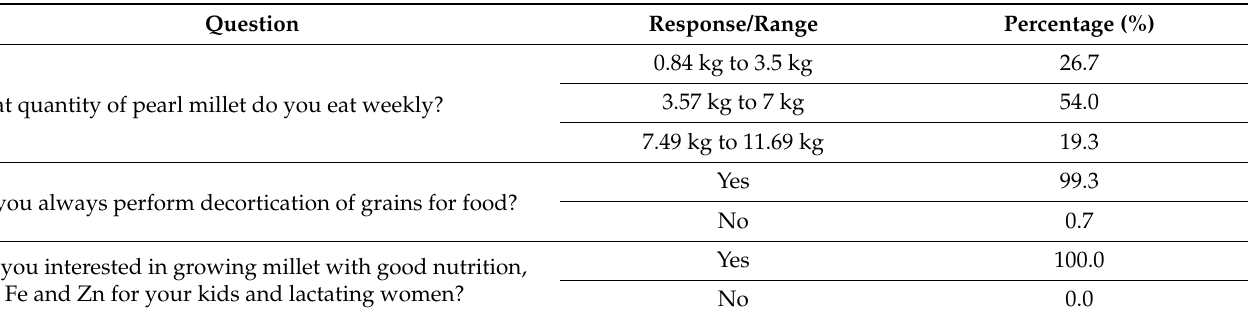
Table 6. Pearl millet consumption in three departments (Dogondoutchi, Dosso, and Gaya) of the Dosso region in Niger.